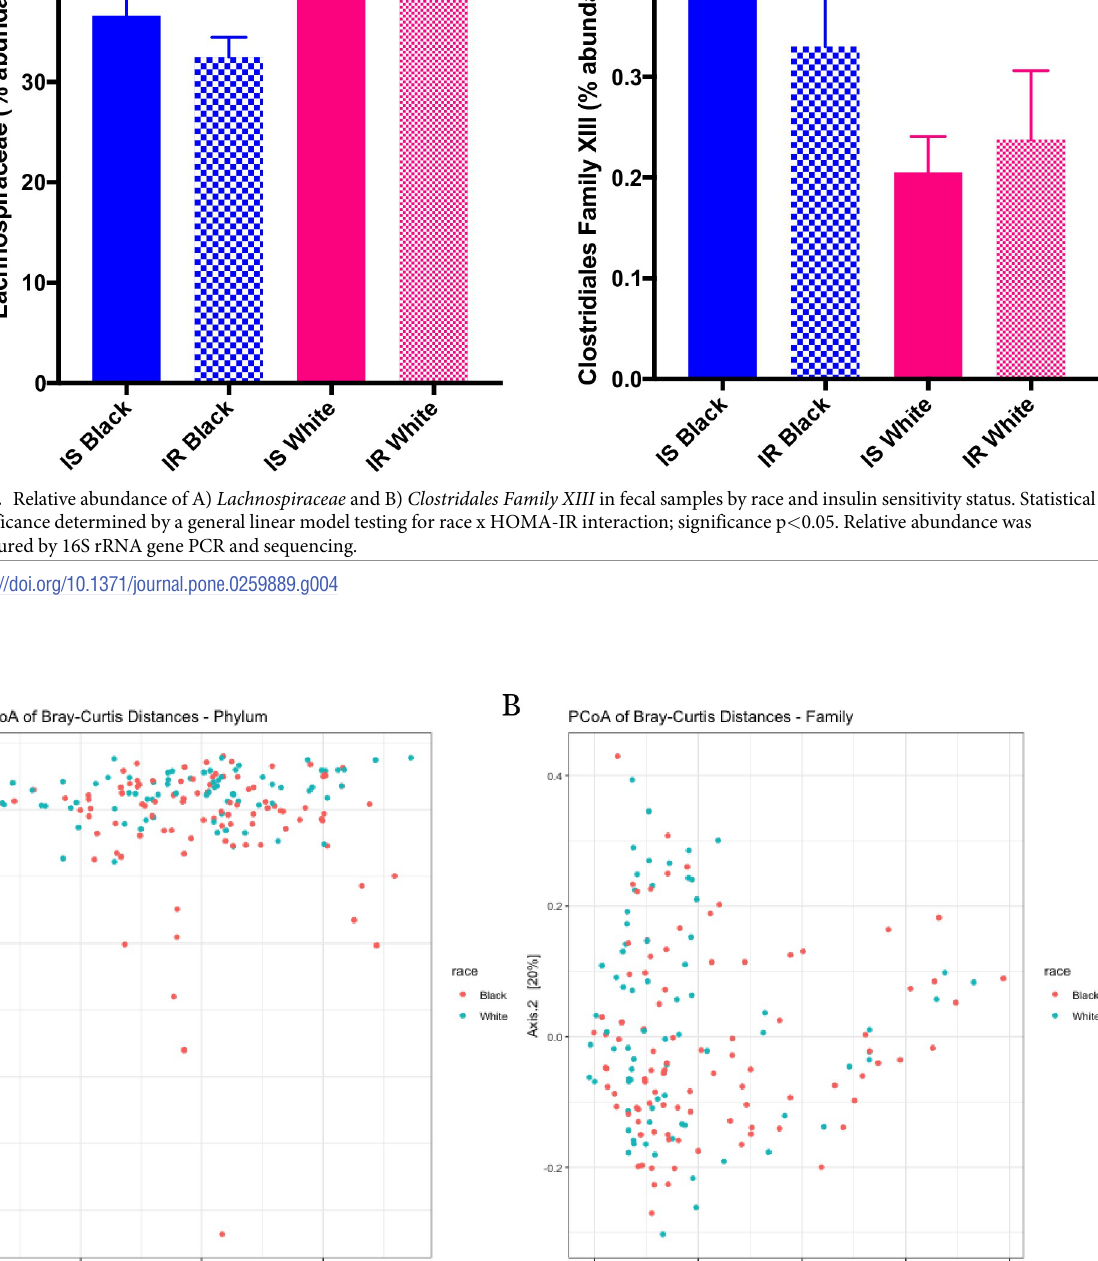
PLOS ONE | https://doi.org/10.1371/journal.pone.0259889 January 19,